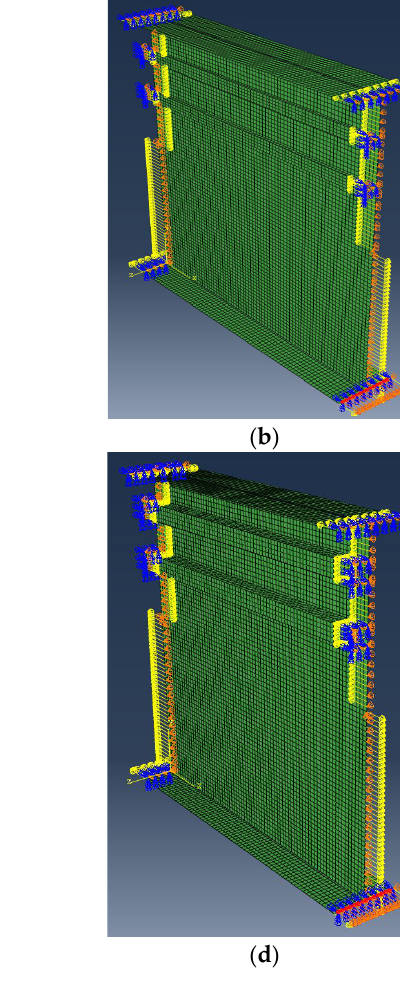
Figure 4. Loading and boundary conditions for various plate girder configurations in Abaqus: ( a ) T section, ( b ) L section, ( c ) triangular section, ( d ) rectangular section.